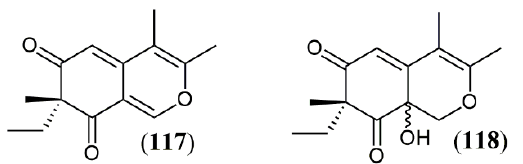
Figure 14. Azaphilones produced by Plenodomus influorescens in co-cultivation with Pyrenochaeta nobilis : 117 : spiciferinone; 118 : 8a-hydroxy-spiciferinone [102].